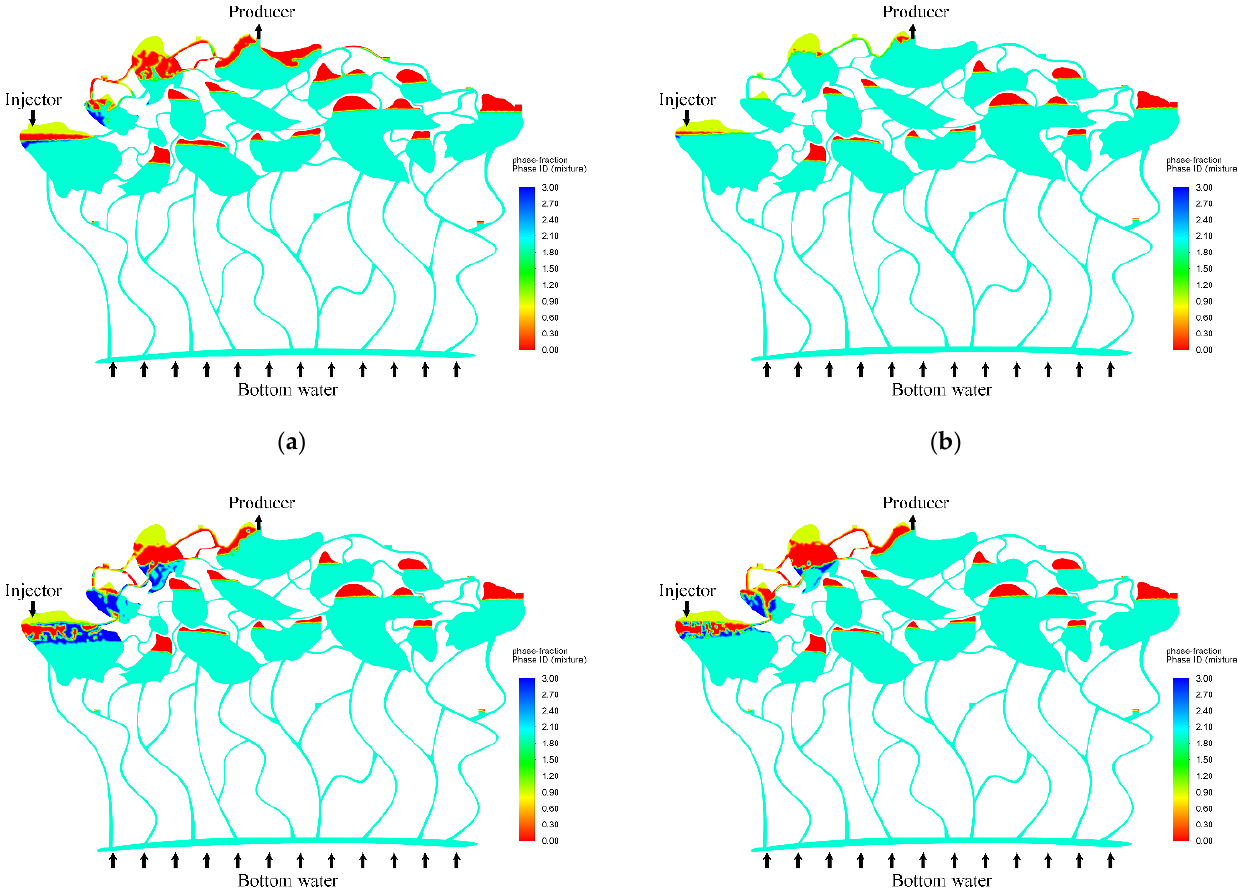
Figure 11. Fluid distribution in different nitrogen injection modes: ( a ) initial time at nitrogen injection; ( b ) intermittent mode; ( c ) gas–water mixed mode; ( d ) gas–water alternate mode.